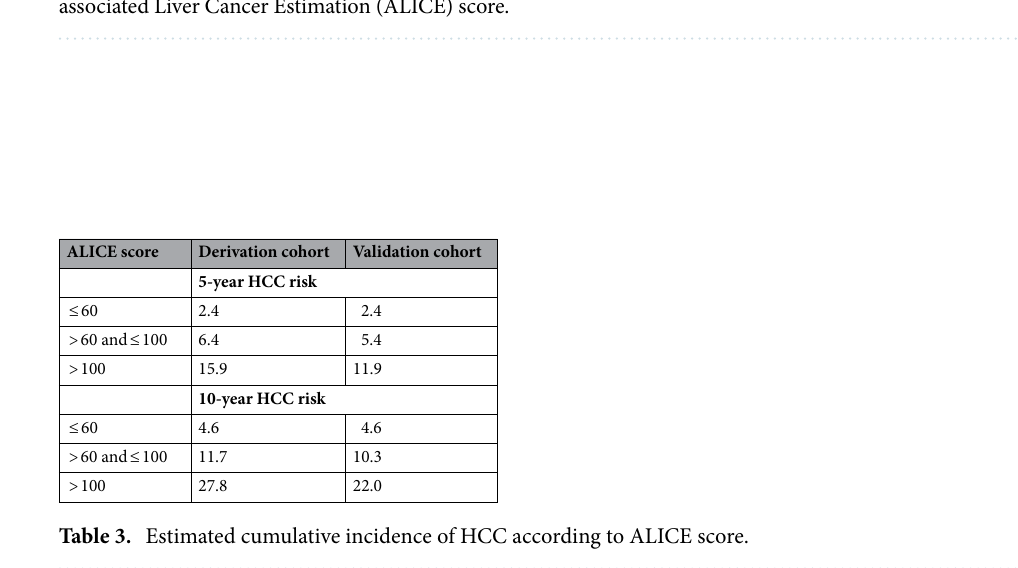
Figure 3. Cumulative incidence curves of HCC in the derivation and validation cohorts according to Alcohol- associated Liver Cancer Estimation (ALICE) score.